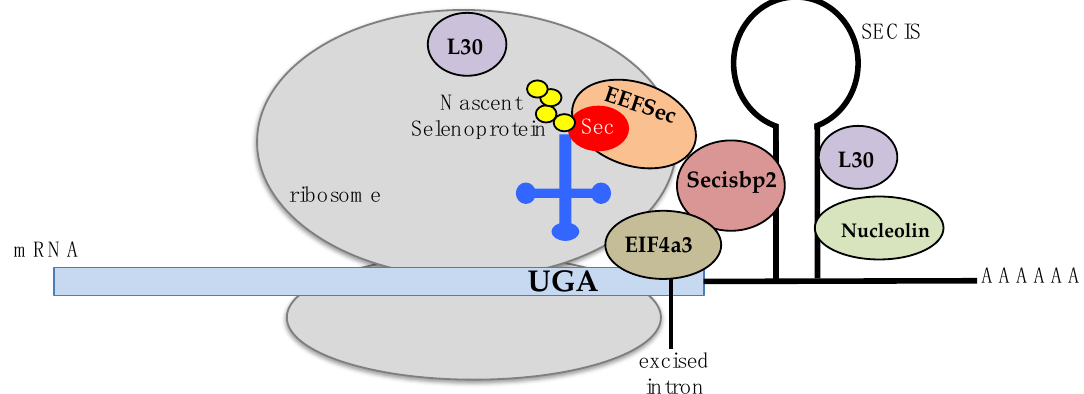
Figure 1. Schematic model of the UGA codon recognition and selenocysteine insertion into selenoproteins. Known participants on this molecular mechanism include proteins Secisbp2 (light red), EEFSec (orange), L30 (purple), nucleolin (green), and EIF4A3 (brown). The Sec-tRNA Sec is represented in dark blue, and a nascent selenoprotein in yellow circles.